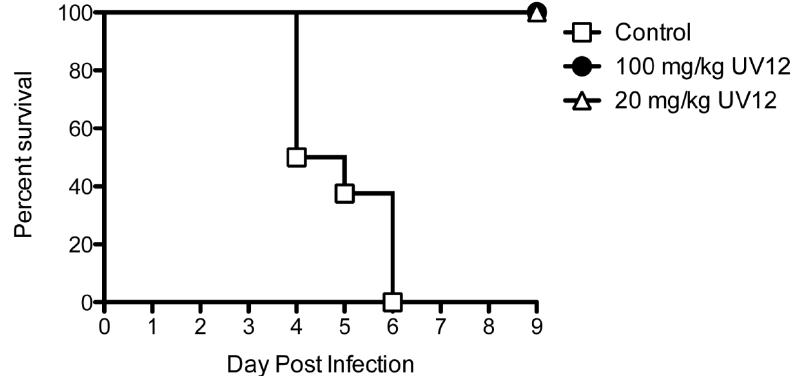
Figure 4. Protection by UV-12 in DENV ADE mouse model. AG129 mice were treated with 100 or 20 mg/kg of UV-12 orally thrice daily for 7 days starting 1 h before challenge using the ADE DENV